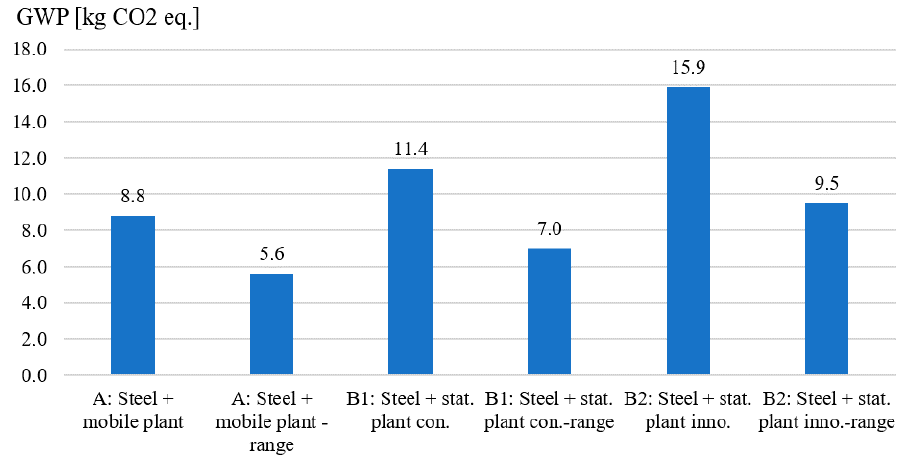
Figure 8. GWP per SRC double wall.